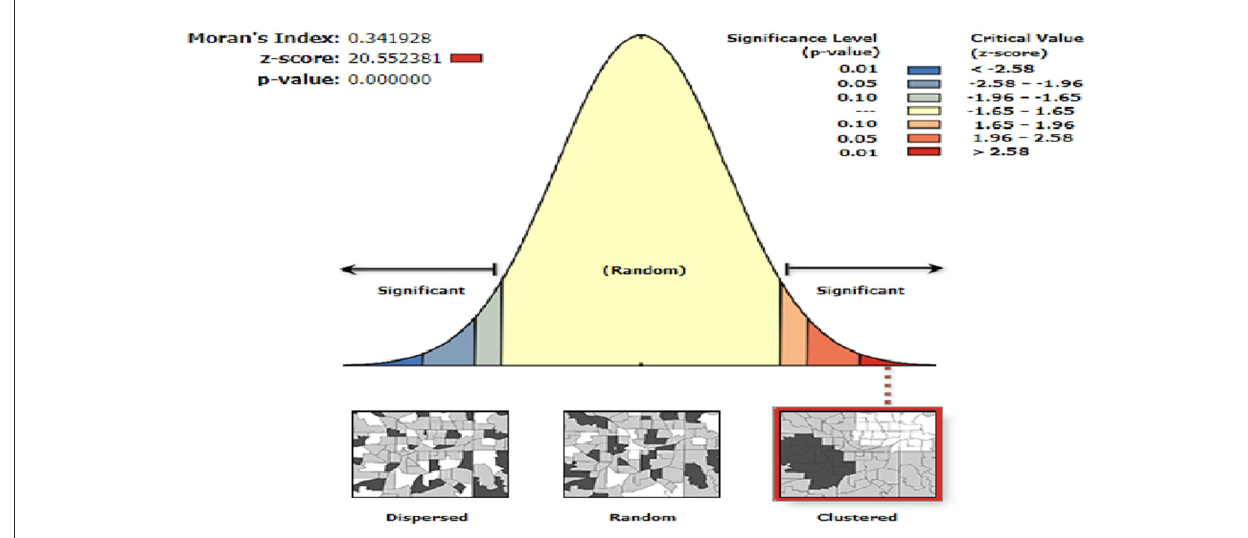
FIGURE1 Global autocorrelation of prenatal HIV test uptake in Ethiopia, 2016.